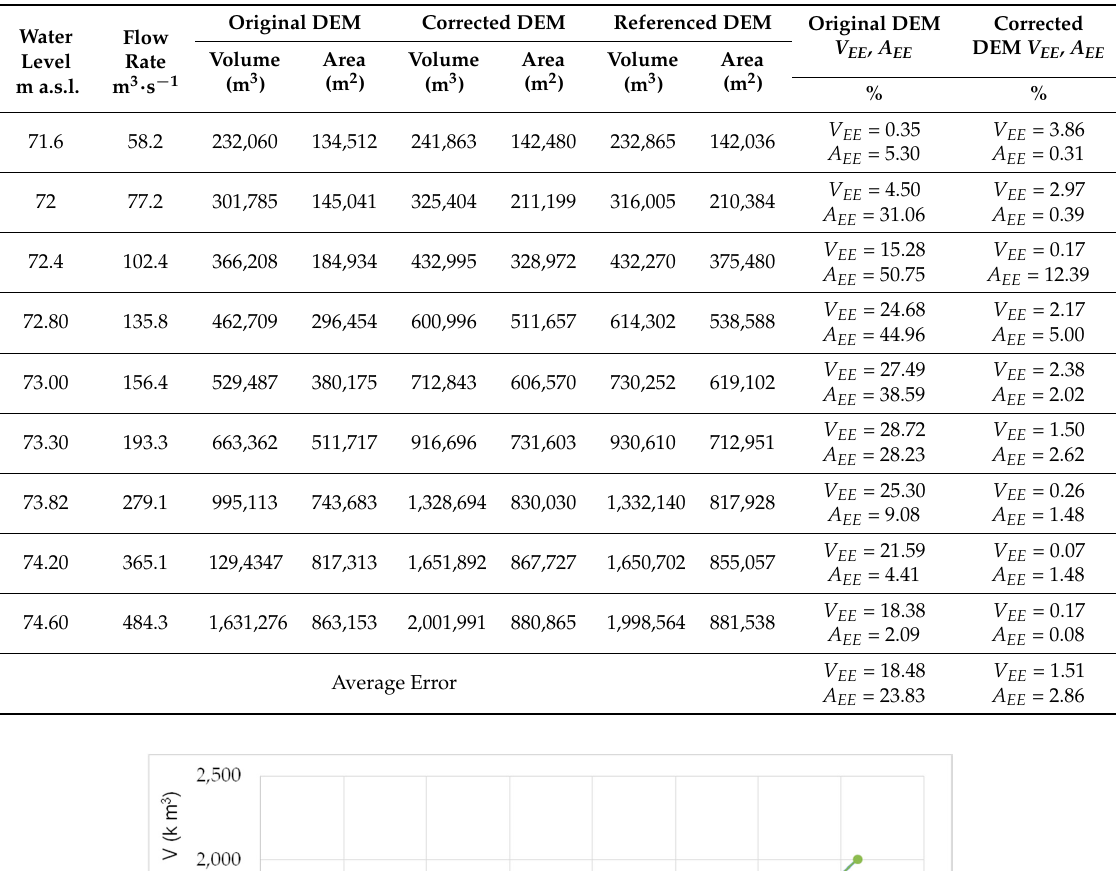
Table 2. Comparison of the results obtained from 2D model based on various DEMs.